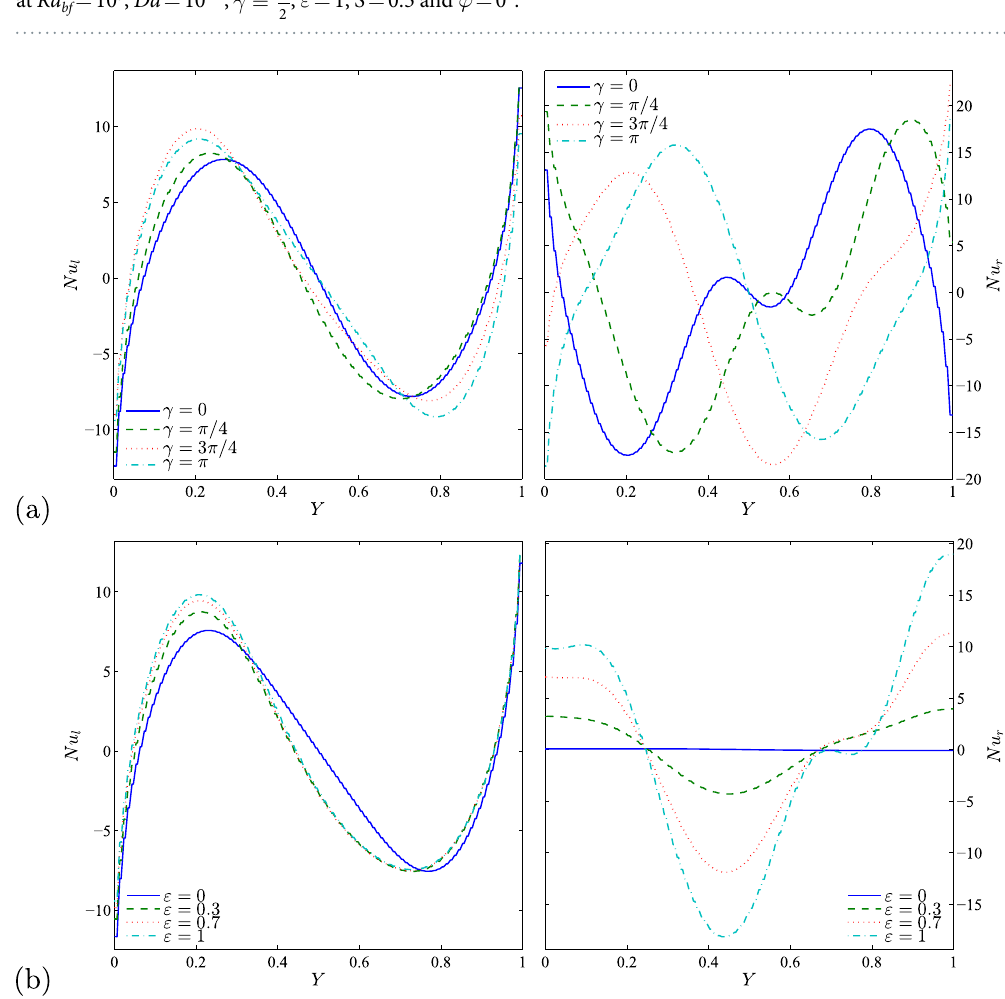
Figure 11. Values of Nu interfaces with Y for ( a ) different γ and ( b ) different ε at Ra bf = 10 5 , Da = 10 − 4 , φ = 0.1, S = 0.5 and ϕ =